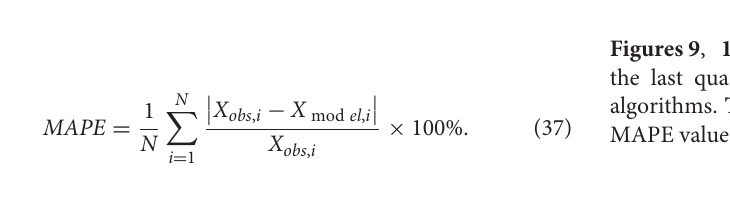
FIGURE 7 | Real values and values predicted by classical SVR algorithm. The samples in the figure are from July 3, 2008 to December 31, 2019, which have 182 samples in total. Each sample in turn corresponds to the number 1–182 of the abscissa.